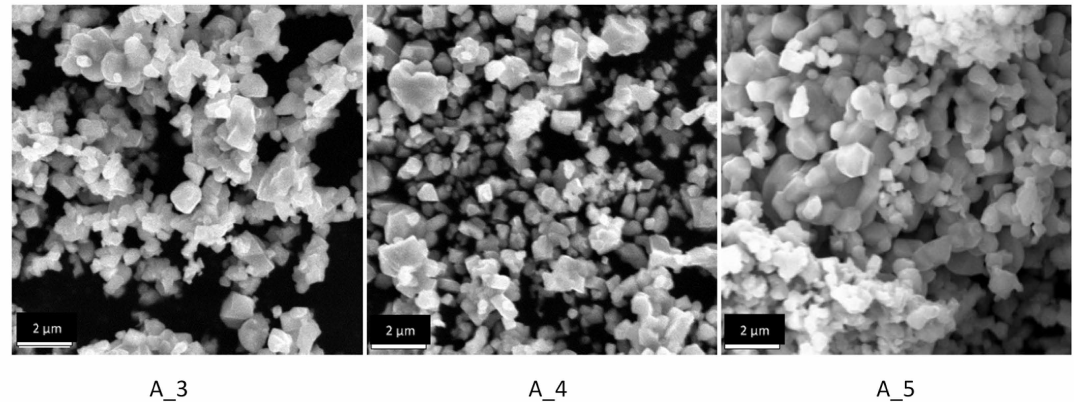
Figure 6. SEM images for the samples A_3 (1000 ◦ C for 48 h), A_4 (1000 ◦ C for 72 h) and A_5 (1000 ◦ C for 96 h).